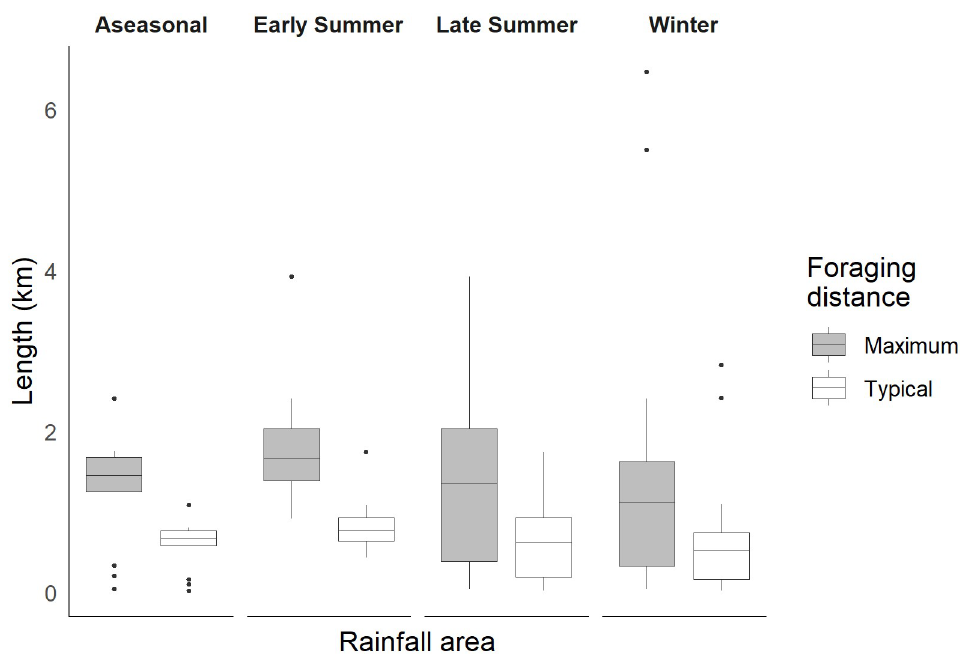
Fig 5. Estimated typical and maximum bee foraging distance across rainfall regions. Each panel represents the four rainfall regions: aseasonal, early summer, later summer and winter. Boxplots of typical and maximum foraging distance for 56 species of Melittidae. Dots represent outliers. Typical and maximum foraging distance were estimated form IT using previously published equations [13].